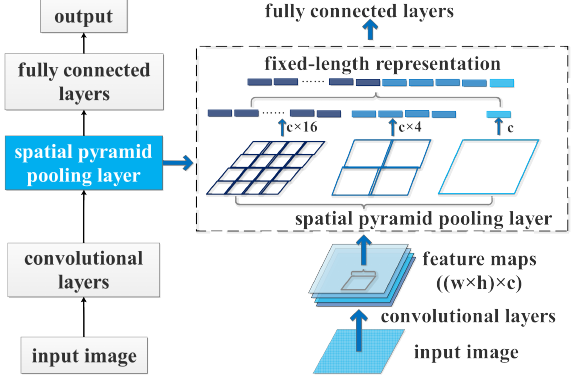
Figure 3. A CNN with a spatial pyramid pooling